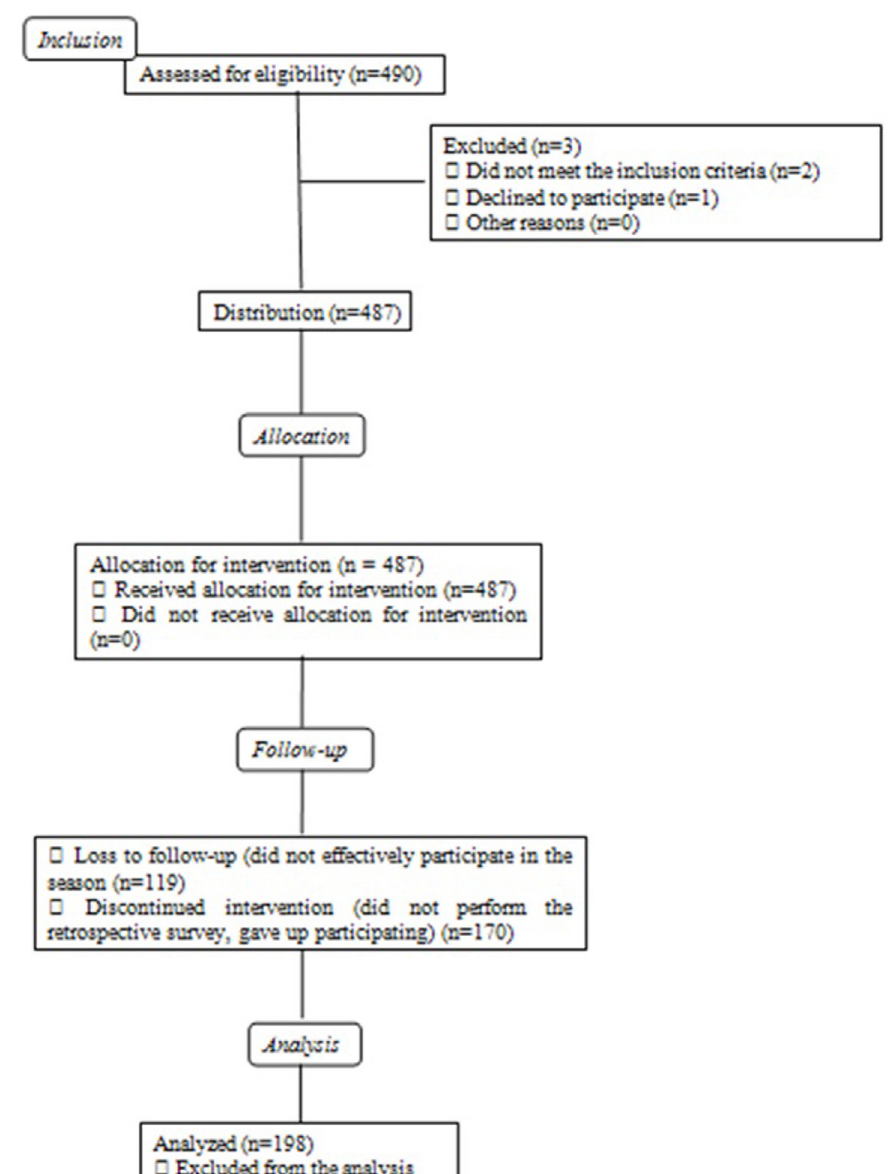
Figure 1. Flow diagram representation of the